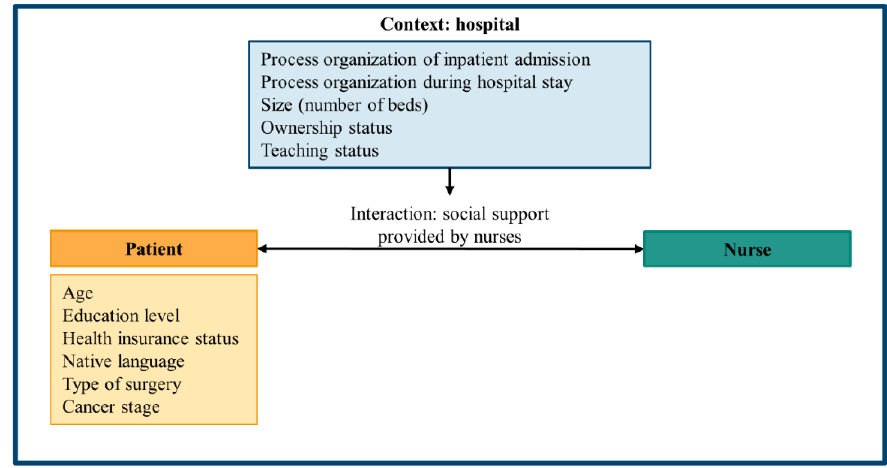
Figure 1. Research model: patient-nurses interaction within contextual factors.